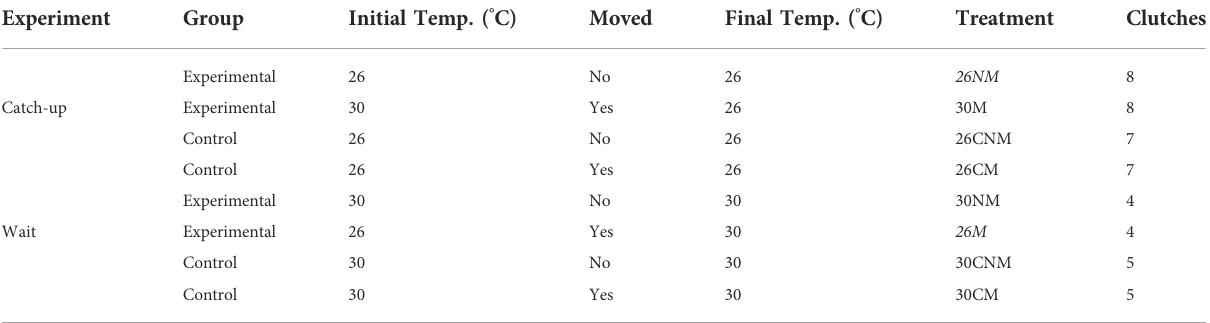
TABLE 1 Experimental groups, treatment designations, and clutch representation. Experiment Group Initial Temp. ( ° C) Moved Final Temp. ( °